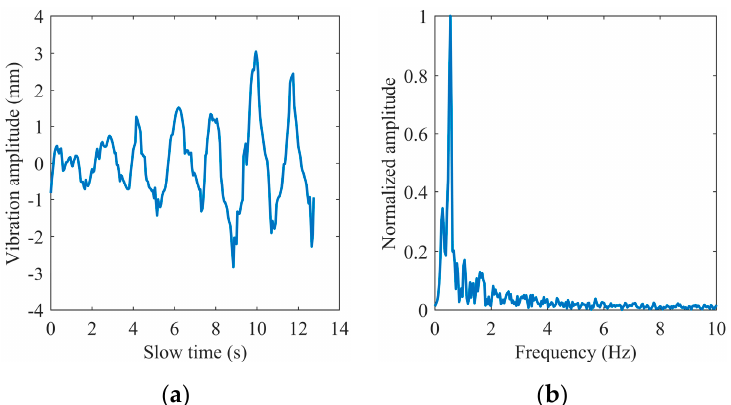
Figure 4. Extracted phase by the extended DACM: ( a ) in the time domain; ( b ) in the frequency do- main.